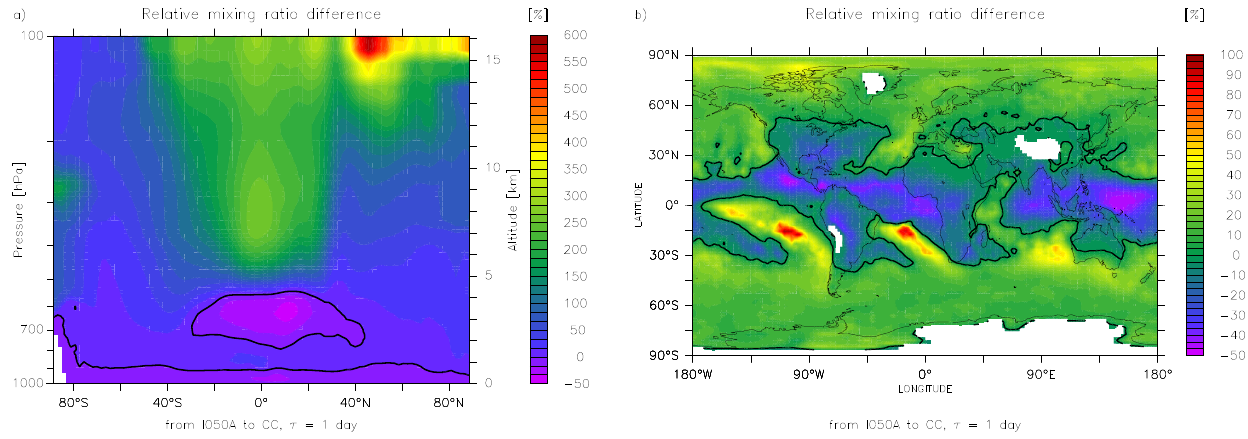
Figure 6. Relative difference in the 2001 averaged mixing ratio of the atmospheric tracer with a lifetime of 1day for CC compared to I050A. Results are shown for (a) the zonally averaged data and (b) the difference at the 700hPa